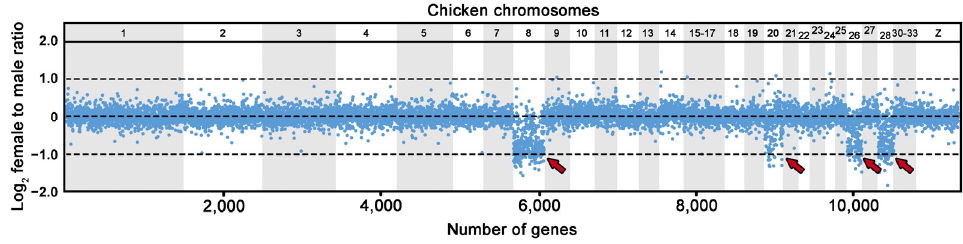
Figure 3. Log 2 -transformed female to male ratios of DNA-seq read coverage per gene in U. henkeli. Due to the lack of a chromosome-level genome assembly for U. henkeli , genes are illustrated based on the position of their orthologs in the chicken genome. The Z-specific genes are expected to show half female to male read coverage ratio (log 2 -transformed ratios of ∼− 1.00) than autosomal and pseudoautosomal genes (log 2 -transformed ratios of ∼ 0.00). Genomic regions with Z-specific genes in U. henkeli (GGA8, GGA20, GGA26, GGA28) are indicated by arrows (all data are available in Table